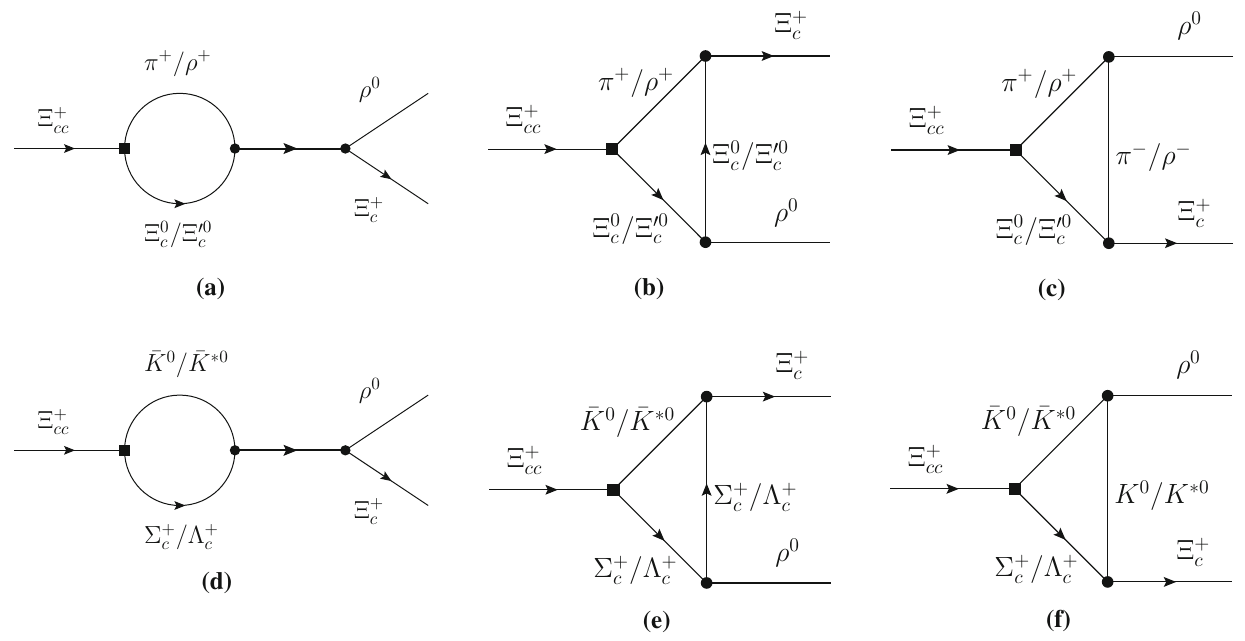
Fig. 2 Leading FSI contributions to (cid:2) + cc → (cid:2) + c ρ 0 manifested at hadron level. The black squares denote weak vertices and dots repre- sent strong vertices. Diagrams a, b and c are induced by the rescattering